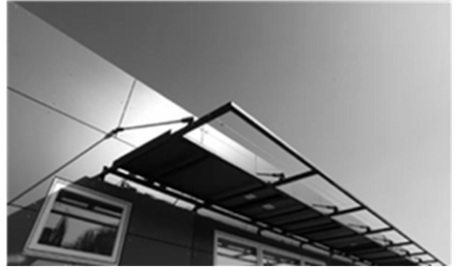
Figure 8. California Polytechnic PV awning. Reprinted from ref. [9].